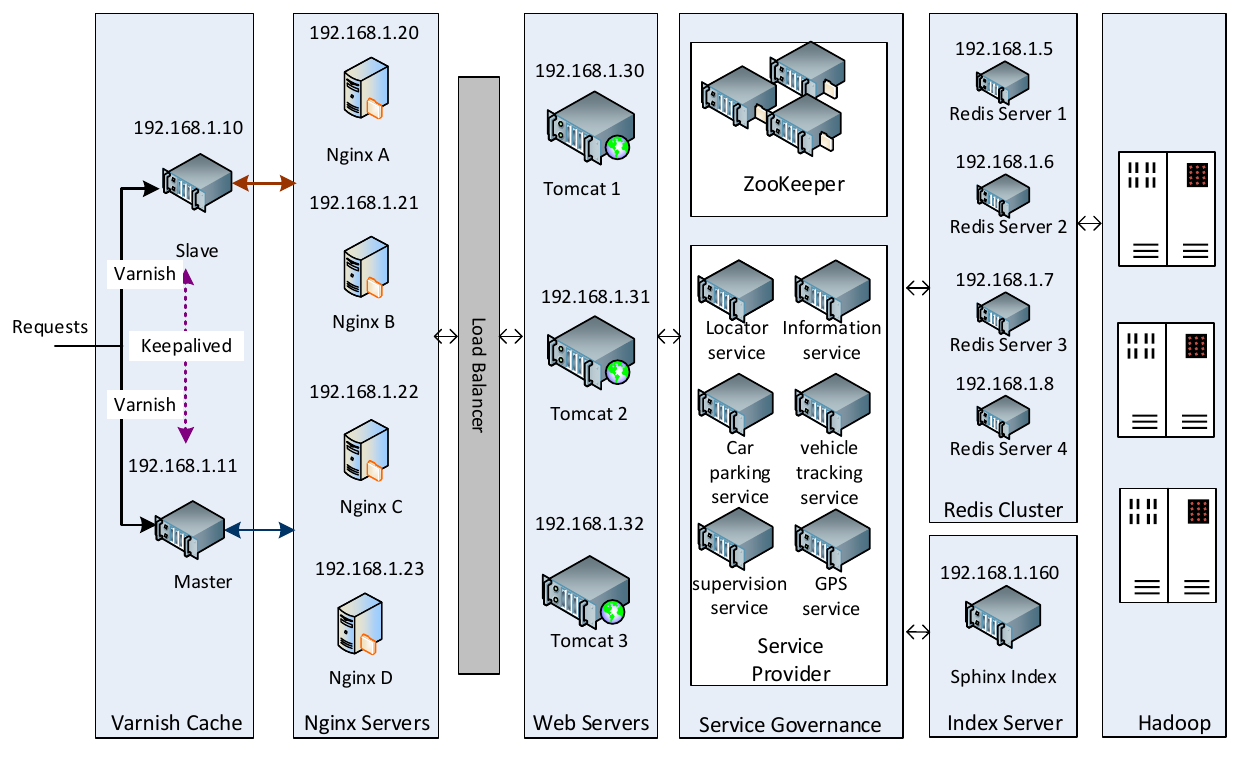
Figure 15. A high-level view of the car parking system